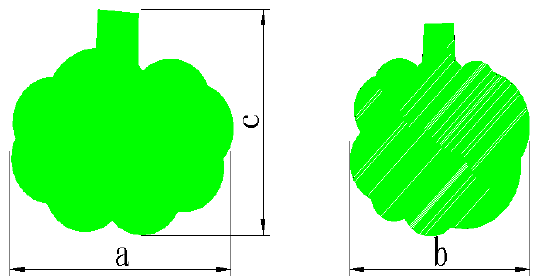
Figure 3. Size diagram of broccoli blocks after the first cutting.